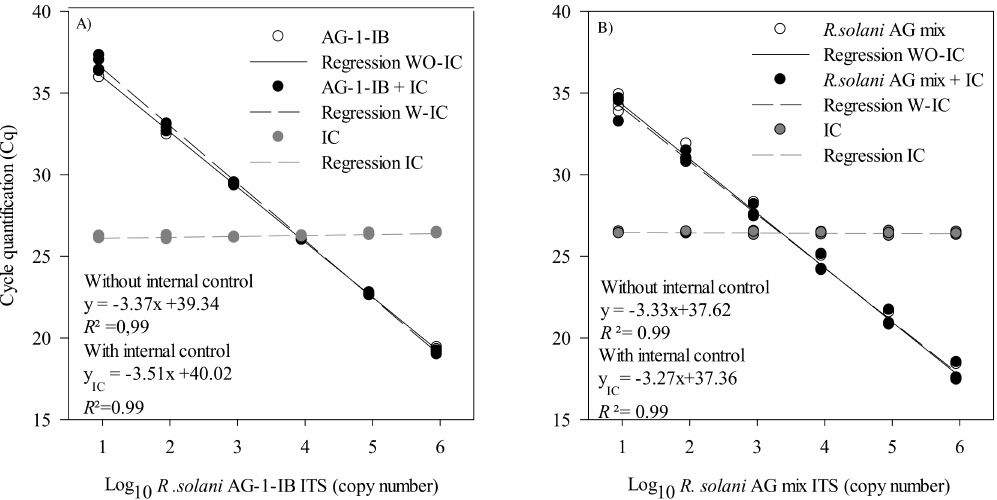
Figure 3. Standard curves and regression of Rhizoctonia solani AG 1-IB and R. solani dilution series measured by qPCR. The cycle quantification threshold (Cq) is plotted against the log 10 of ( A ) the R. solani AG1-IB ITS copy number with and without the EIPC100 internal control (IC) and ( B ) the number of R. solani AG-mix ITS copies with and without the EIPC100 IC. The results are from three independent experiments. These experiments were conducted using three biological replicates and two technical replicates for each biological replicate. Cq values for these experiments are provided in Supplementary Tables S3 and